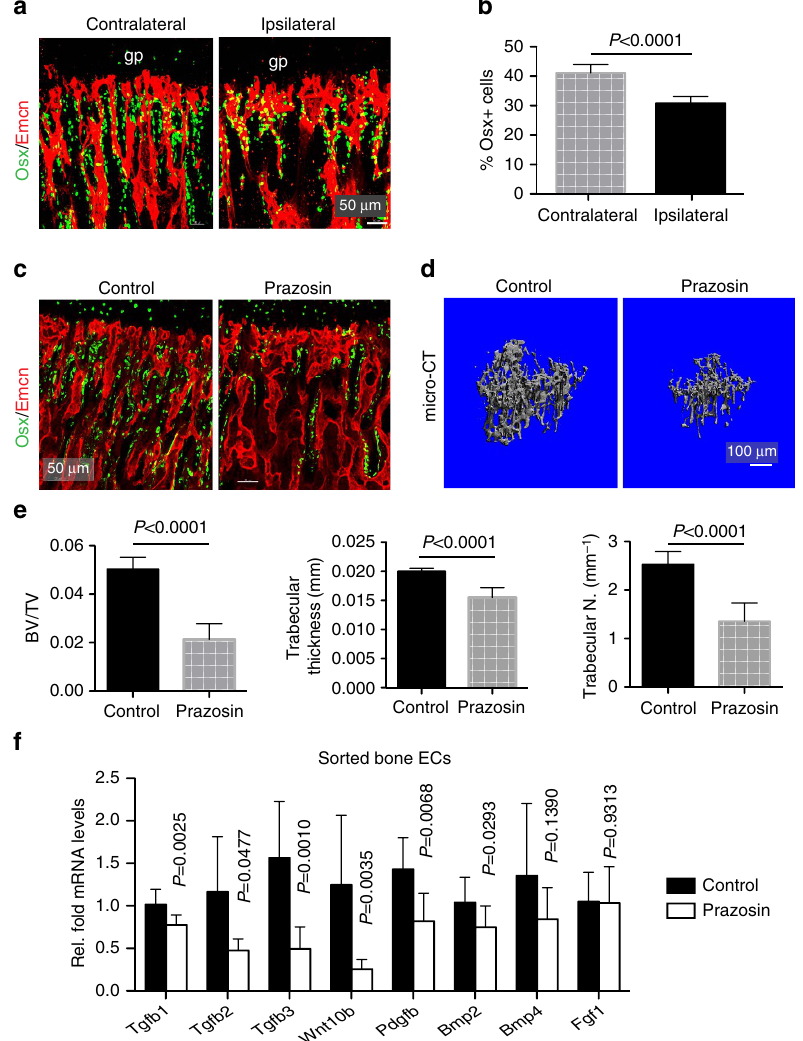
Figure 4 | Flow-mediated angiogenesis is coupled to osteogenesis. ( a ) Maximum intensity projections of Emcn (red) and Osterix (Osx, green) immunostaining in contralateral (control) and ipsilateral (ligated) tibia at 48 hps after femoral artery ligation. ( b ) Quantitation of Osx þ cells in contralateral and ipsilateral tibia after femoral artery ligation. Data represent mean ± s.e.m ( n ¼ 5 mice in three independent experiments). P values, two-tailed unpaired t test. ( c ) Confocal images of Prazosin and control tibial sections immunostained for Emcn (red) and Osterix (Osx, green). ( d ) 3D rendering showing micro-CTanalysis of mineralized regions in the metaphysis of control and Prazosin-treated tibiae. ( e ) Histomorphometrical data derived from micro-CT scans. Note reduced bone parameters after Prazosin treatment. ( f ) RT-qPCR for the expression of known pro-osteogenic factors such as Tgfb1 , Tgfb2 , Tgfb3 , Wnt10b , Pdgfb , Bmp2 , Bmp4 and Fgf1 (normalized to Actb expression) in sorted bone ECs from control and Prazosin-treated mice. Data represent mean ± s.d. ( n ¼ 8 biological replicates). P value, two-tailed unpaired t